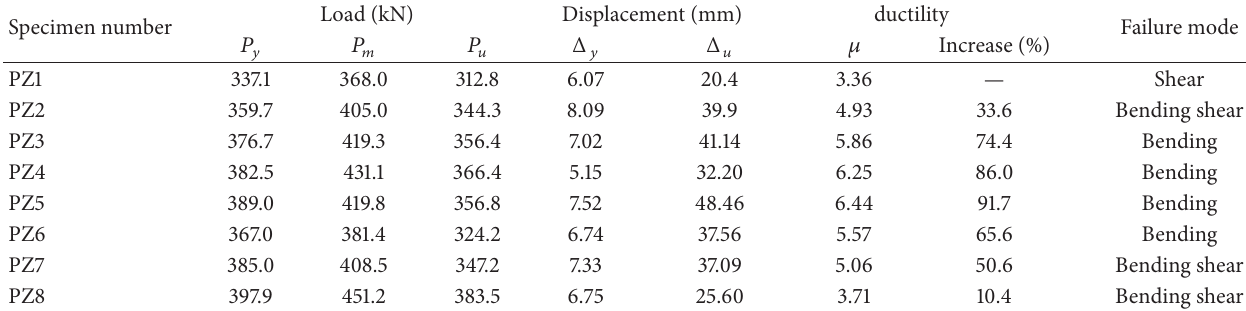
Table 2: Test results of key points in 𝑃 - Δ